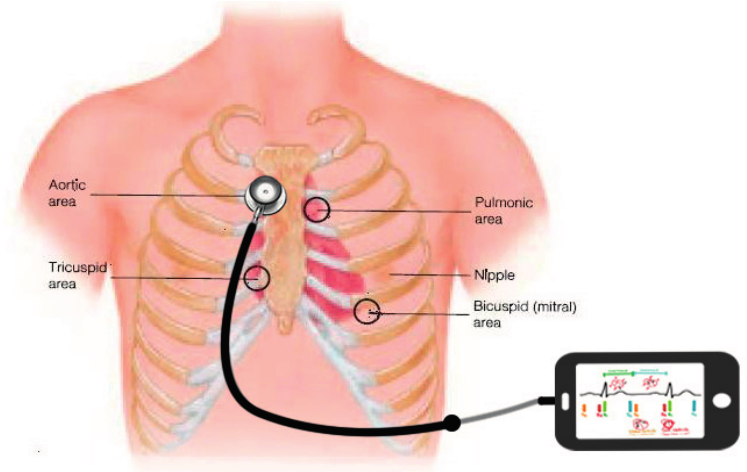
Figure 1. Schematic diagram for heart sound acquisition using a smartphone.